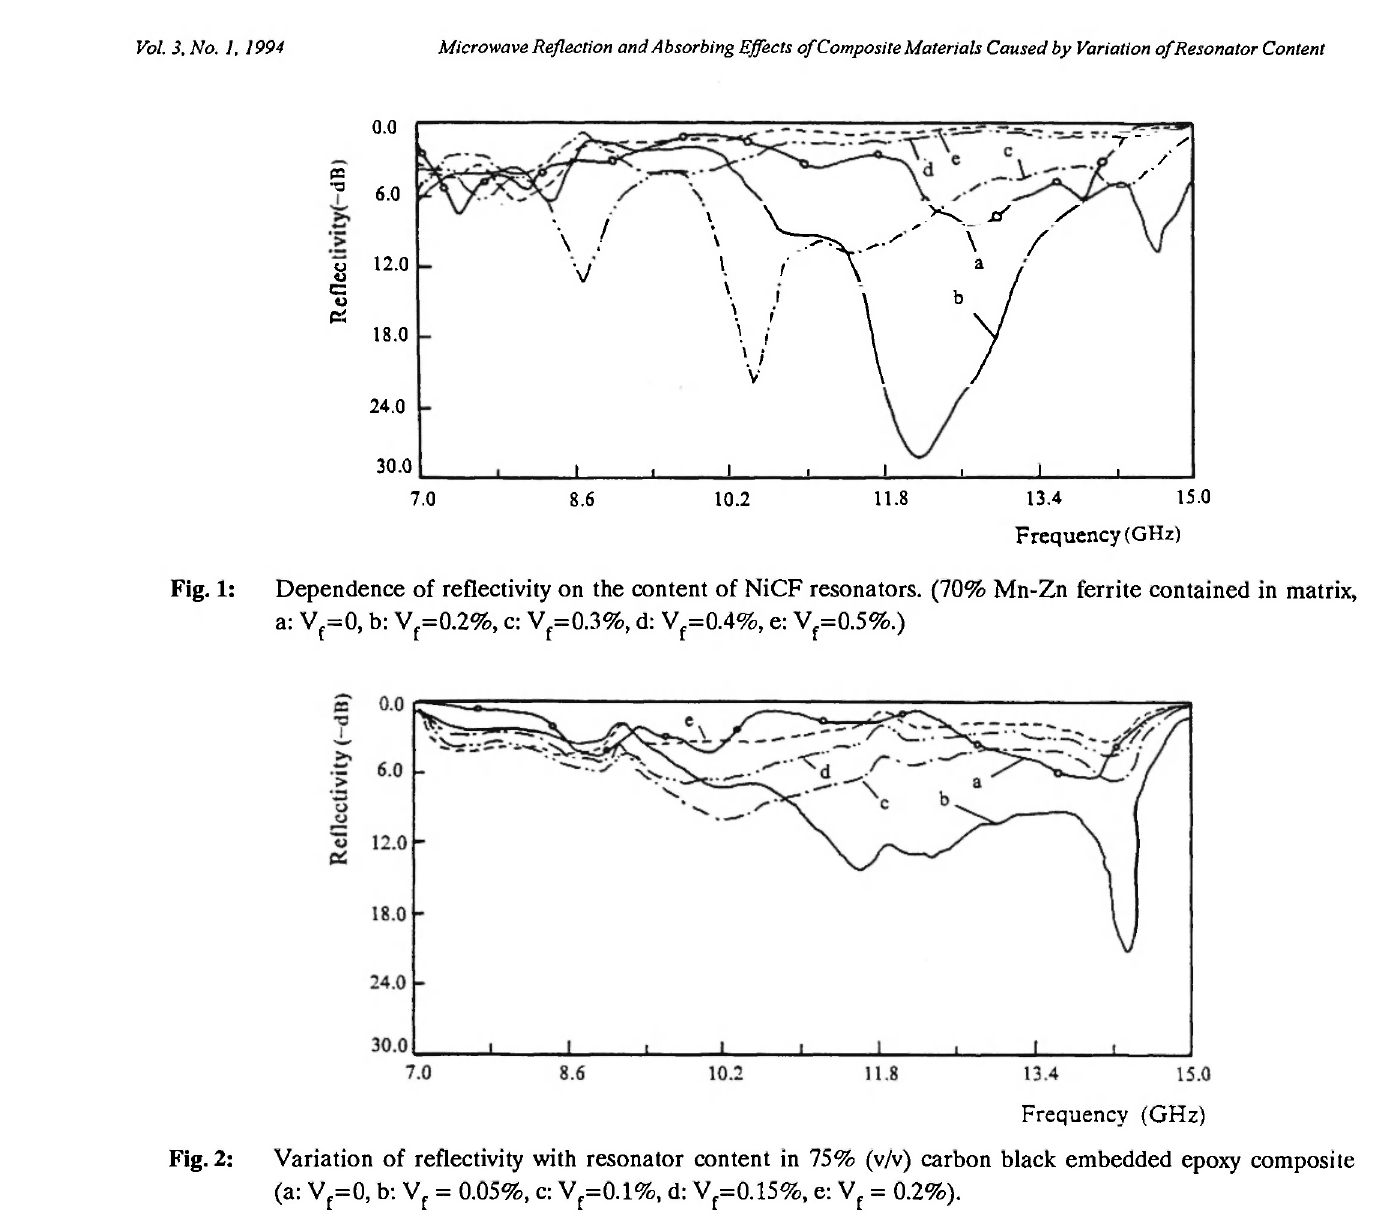
Fig. 2: Variation of reflectivity with resonator content in 75% (v/v) carbon black embedded epoxy composite (a: V f =0, b: V f = 0.05%, c: V f =0.1%, d: V f =0.15%, e: V f =